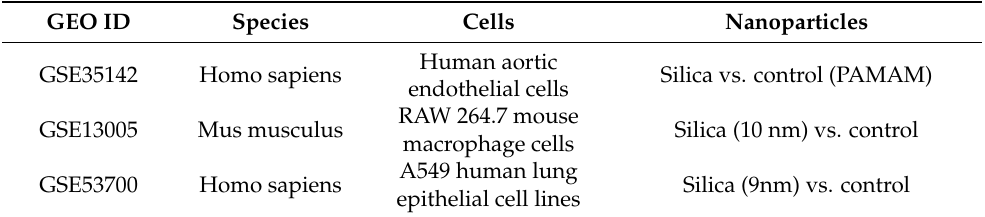
Table 4. Three microarray data sets were used to identify the genes and gene pathways regulated by silica